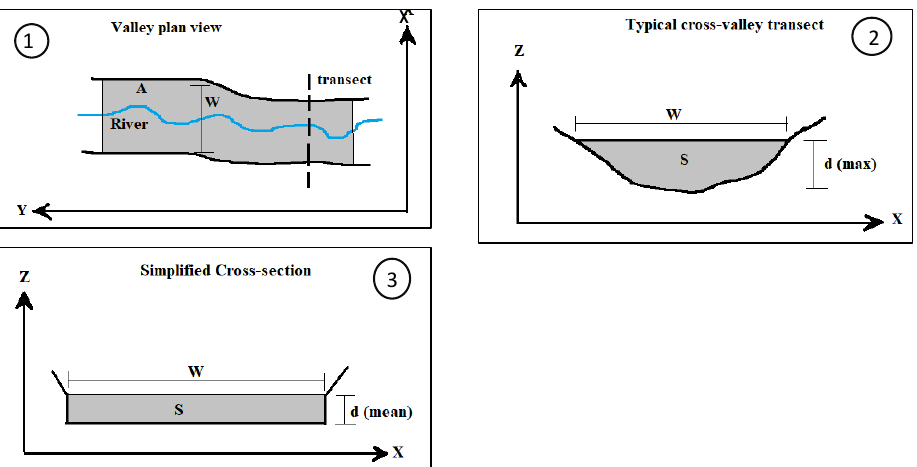
Figure 3. Method of floodplain sediment storage calculation. A is the area of the floodplain, W is the floodplain width, S is the area of sediment in a cross-valley transect and d (max) is the maximum thickness of the valley fill (modified after [2]).